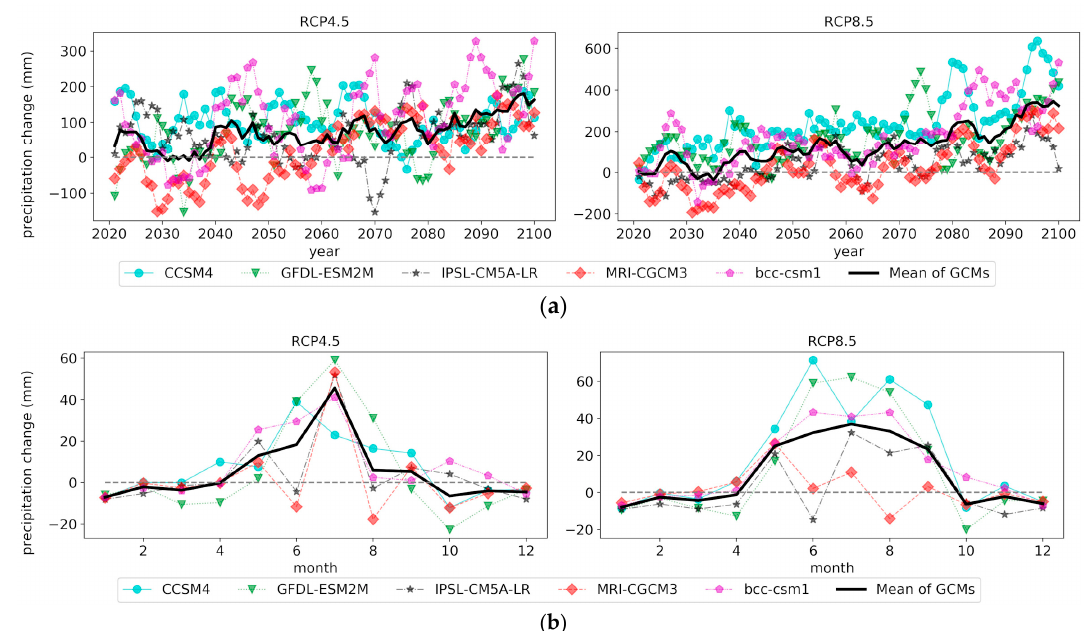
Figure 2. Yearly and monthly change in precipitation (mm) in Lancang River catchment between projected 2020 – 2100 and historical 1961 – 2016. ( a ) Yearly change in precipitation, and ( b ) monthly change in precipitation.